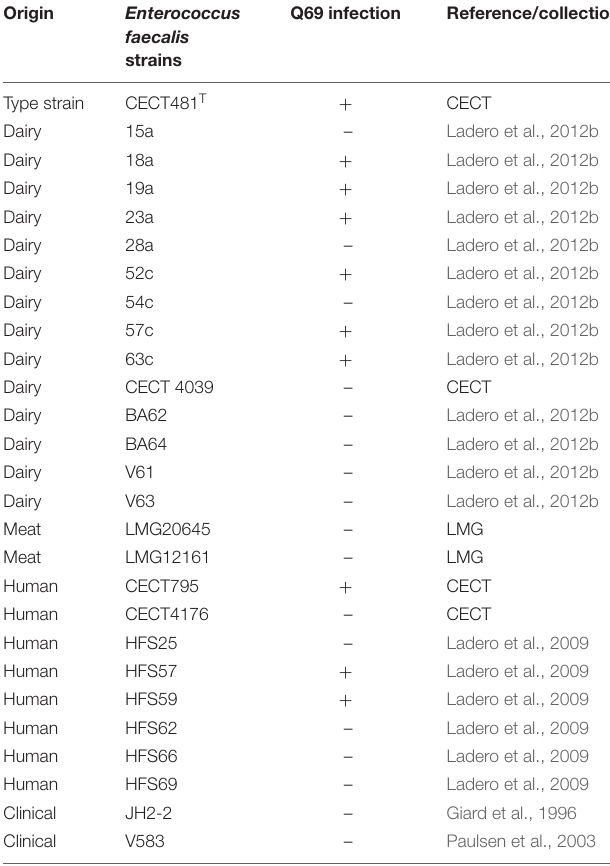
TABLE 1 | Host range determination for phage